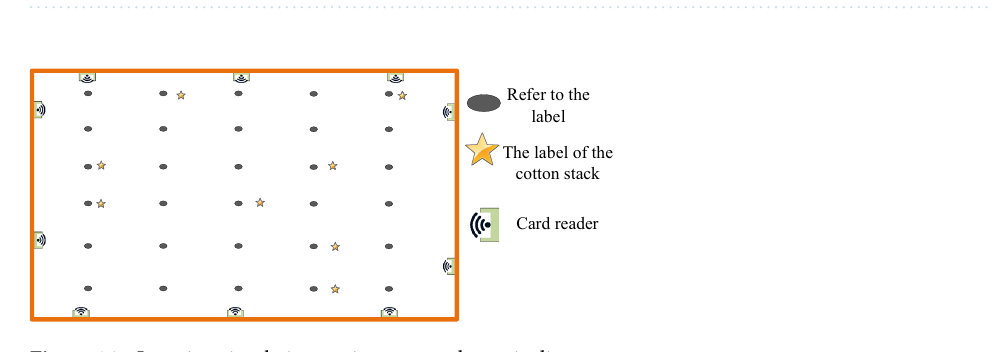
Figure 14. Location simulation environment schematic